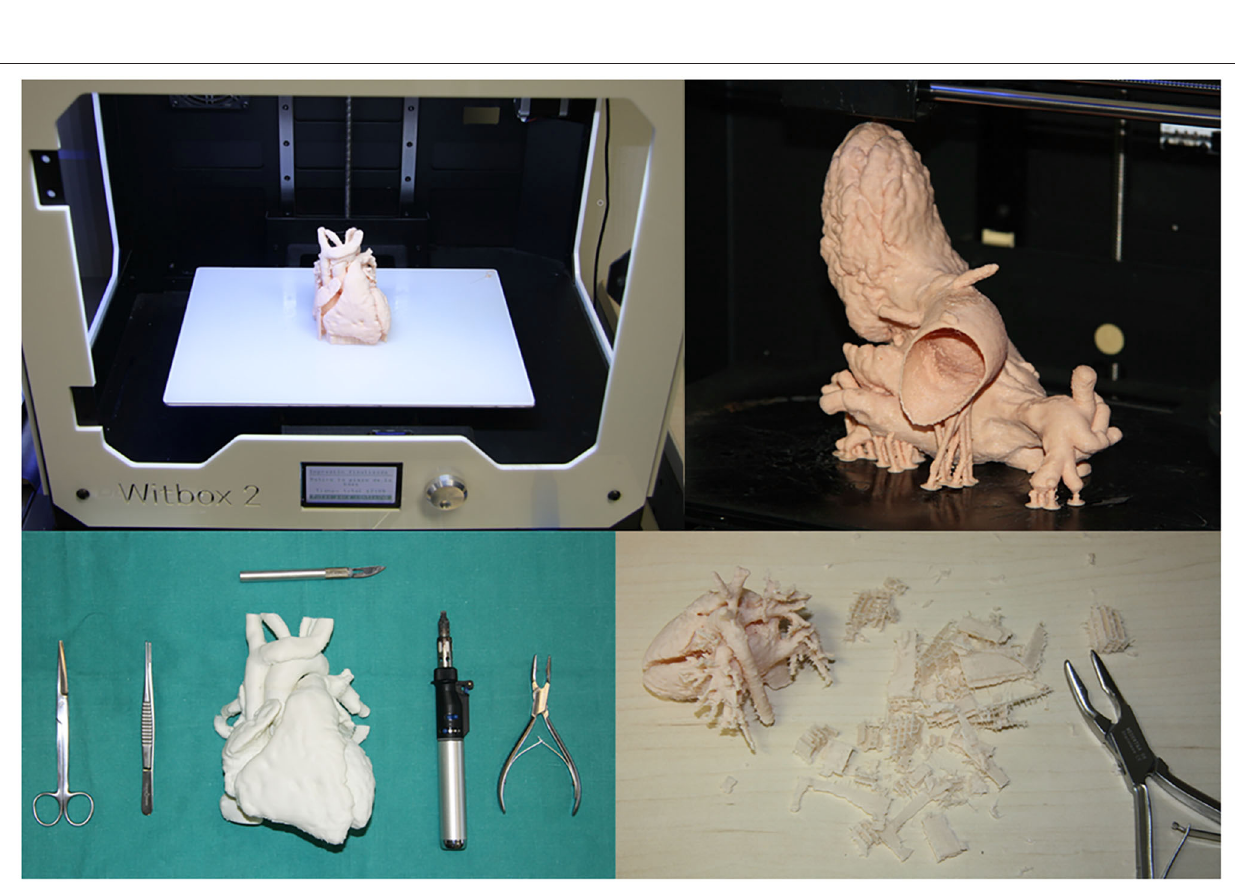
Frontiers in Cardiovascular Medicine |